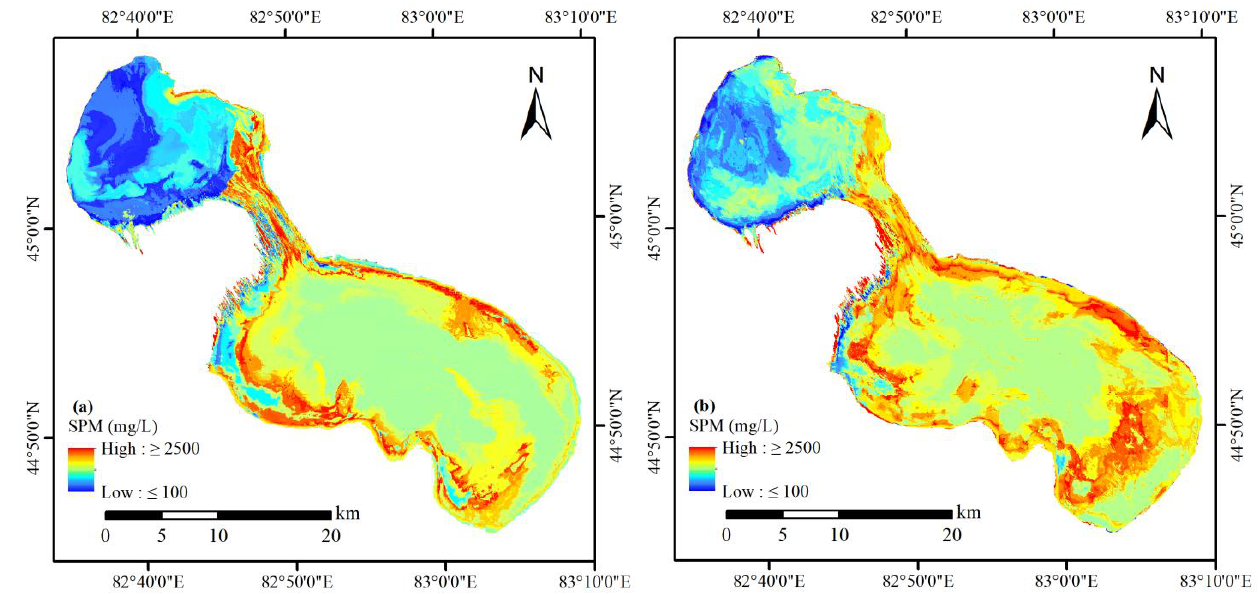
Figure 7. Inversion of SPM concentration distribution from Landsat 8 and ESTARFM fusion images.